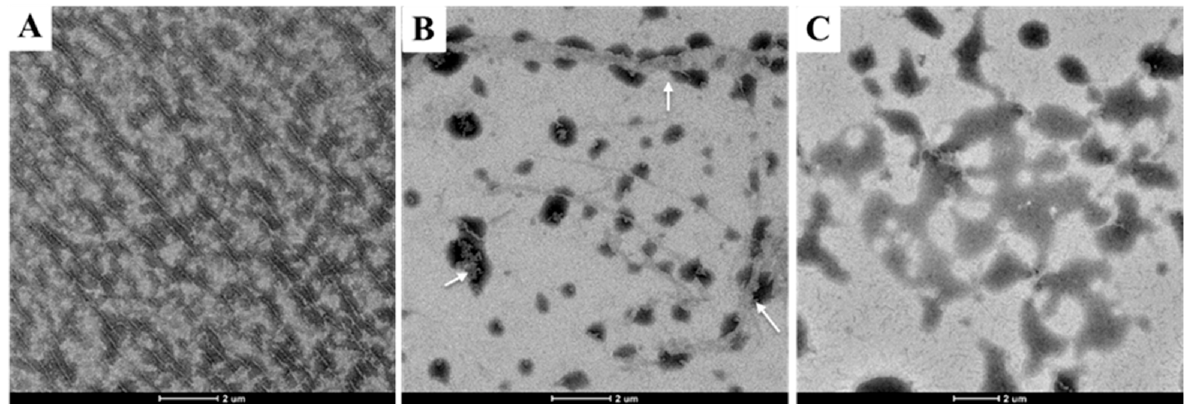
Figure 5. Effect of different concentrations of compound I 23 on tubulin polymerization: ( A ) 4 mg/mL tubulin, ( B ) 20 μ M I 23 + 4 mg/mL tubulin, ( C ) 20 μ M I 23 without tubulin. Scale bars are 2 μ m.